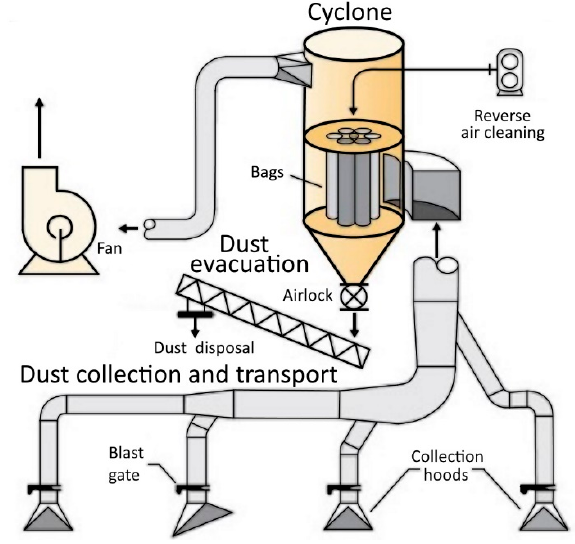
Figure 3. Schematic of a dust collection system.